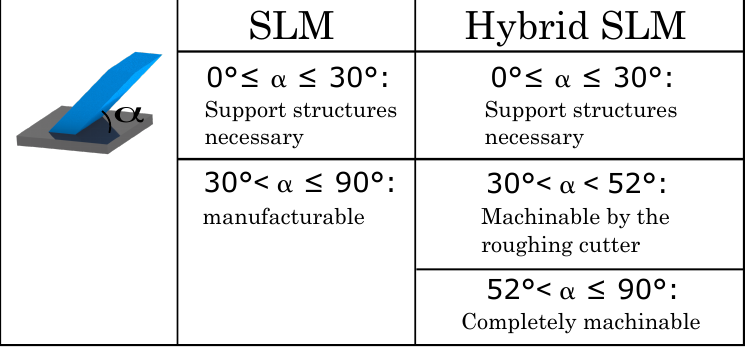
Figure 10. Contruction rule for the manufacturing of inclined